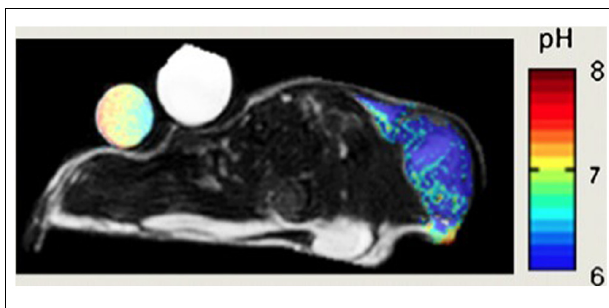
FIGURE 6 | pH map of mouse MCF-7 breast tumor model. pH was measured by administration of a paramagnetic CEST (Chemical Exchange SaturationTransfer) MRI using pH-sensitive contrast agent ytterbium- 1,4,7,10-tetraazacyclododecane-1,4,7 tetraacetic acid, 10-oaminoanilide. Adapted from Zhang etal. (2010) reproduced with